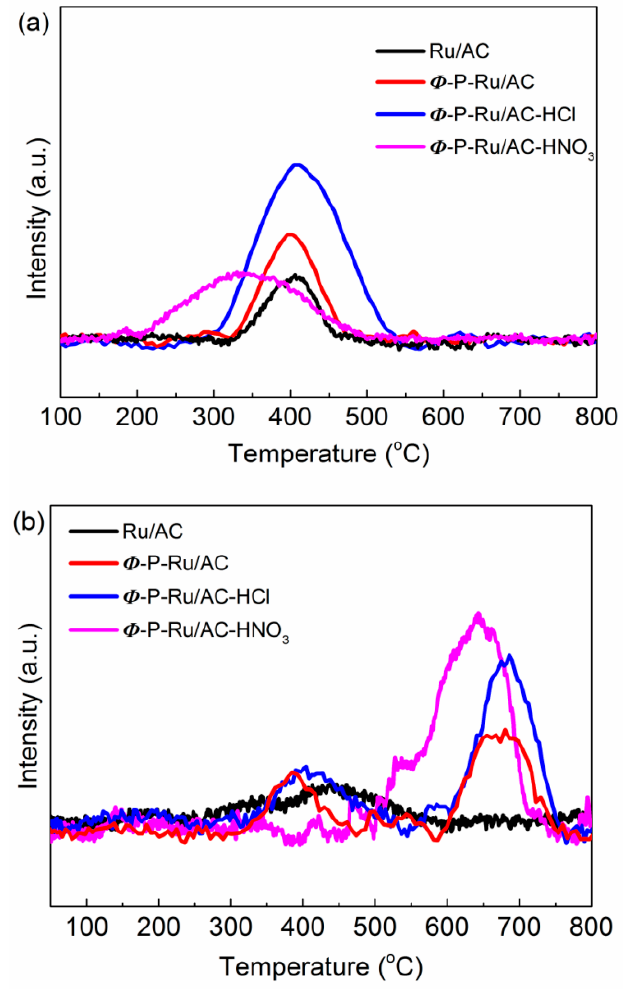
Figure 6. C 2 H 2 - ( a ) and HCl- ( b ) TPD profiles of the fresh Ru-based catalysts.